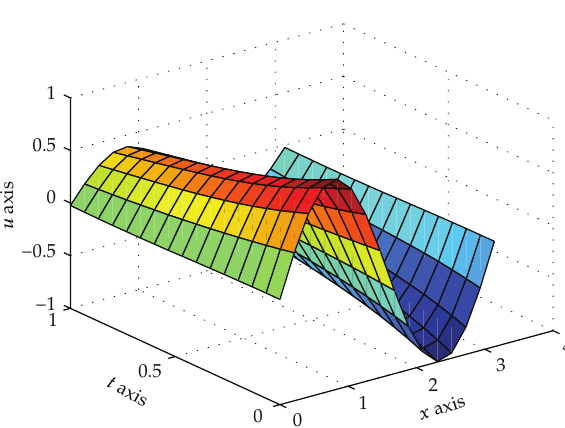
Figure 2: Numerical solution obtained by using the first-order di ff erence scheme.